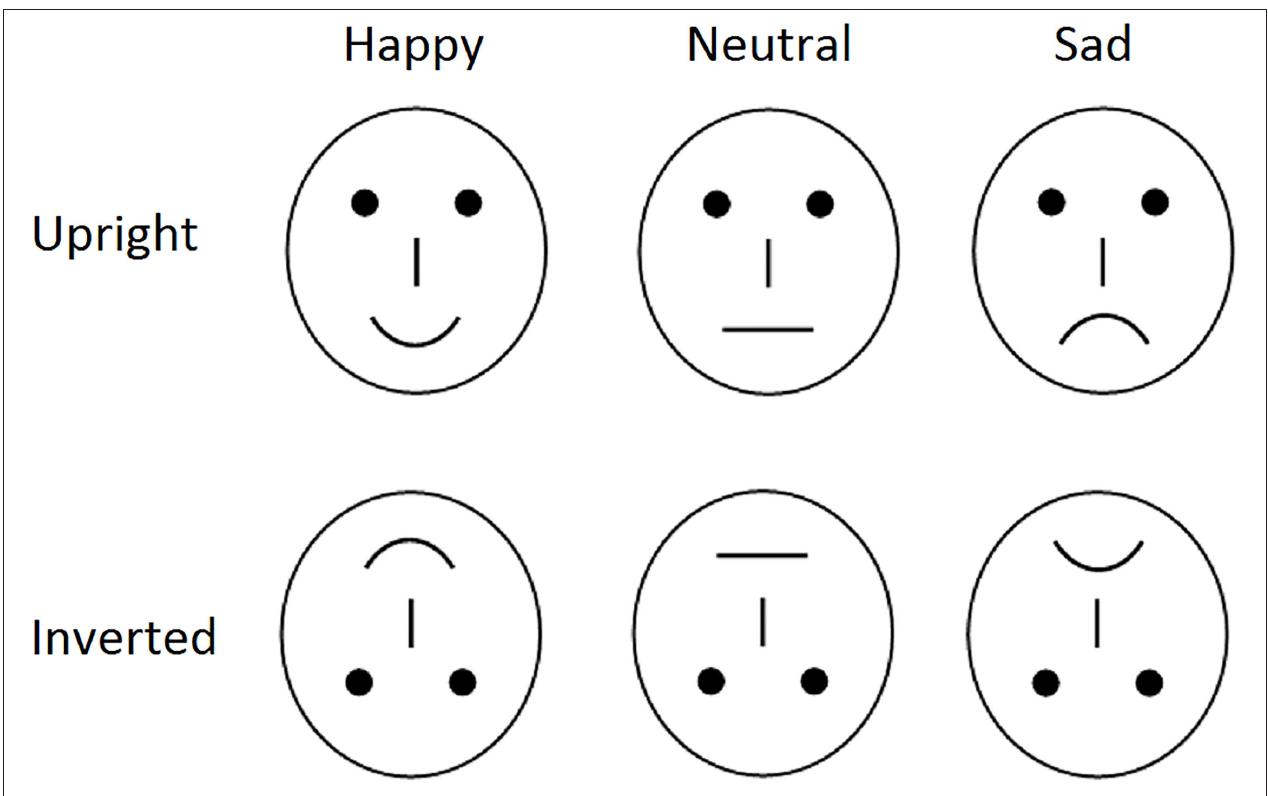
FIGURE 1 | Schematic stimuli used in the present study.